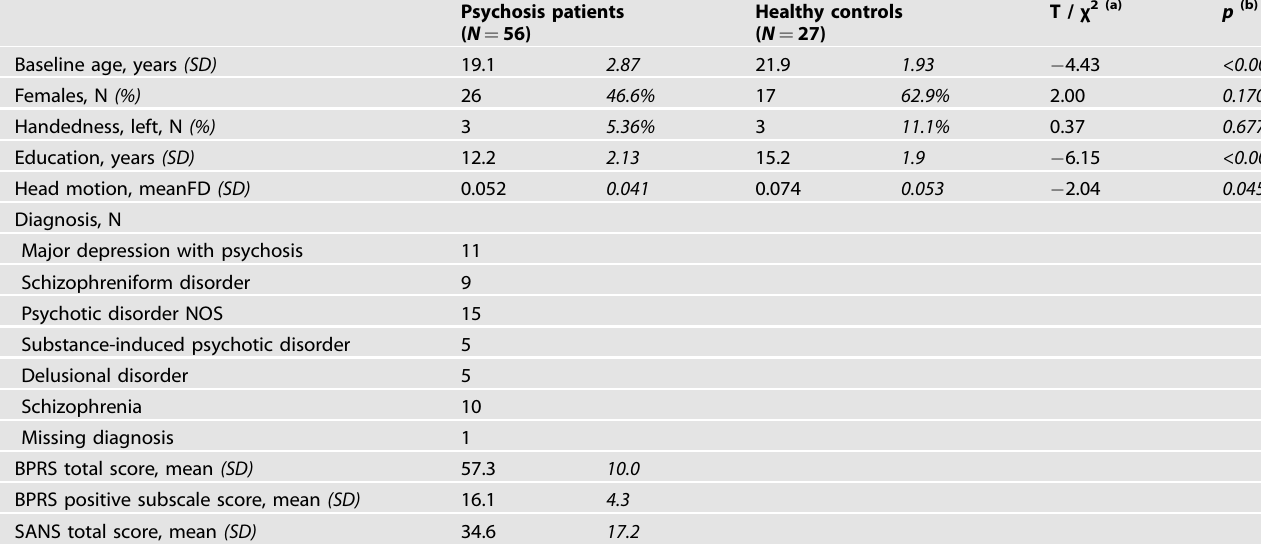
Table 1. Sample characteristics of the FEP